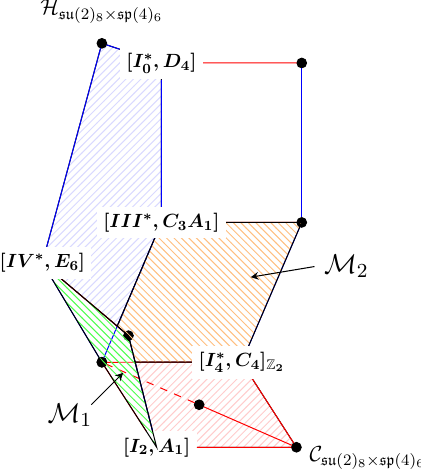
Figure 25. The Hasse diagram for the full moduli space of the su (2) 8 (cid:2) sp (4) 6 theory. We have highlighted in green ( M 1 ) and orange ( M 2 ) the two mixed branch strata discussed in the text. is of the same complex dimension as the Coulomb branch of the superconformal theory.